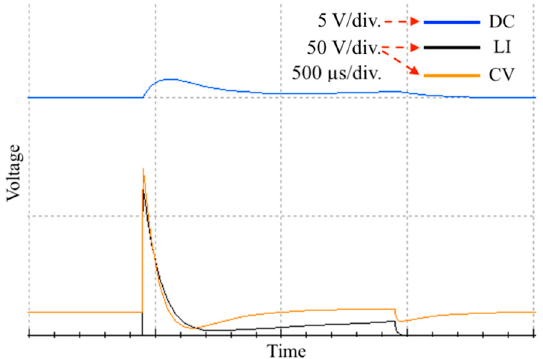
Figure 6. The waveforms obtained as a result of the analysis made with 320 k Ω coupling resistor.